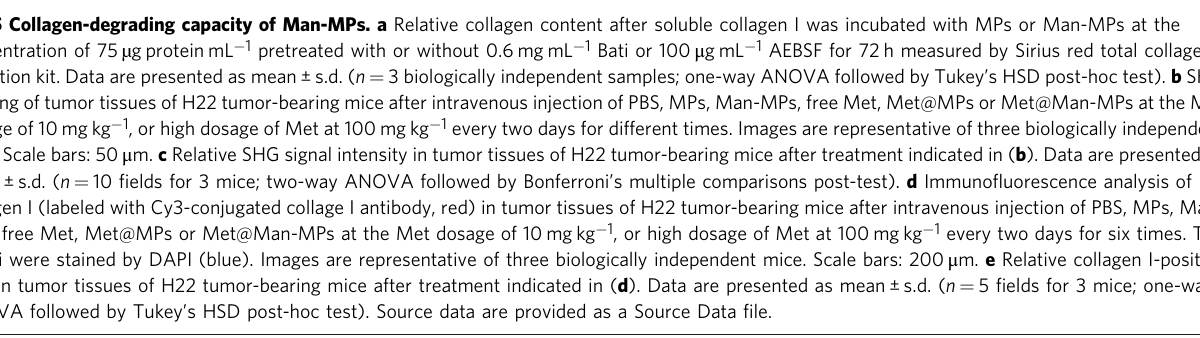
Fig. 5 Collagen-degrading capacity of Man-MPs. a Relative collagen content after soluble collagen I was incubated with MPs or Man-MPs at the concentration of 75 µ g protein mL − 1 pretreated with or without 0.6 mg mL − 1 Bati or 100 μ g mL − 1 AEBSF for 72 h measured by Sirius red total collagen detection kit. Data are presented as mean ± s.d. ( n = 3 biologically independent samples; one-way ANOVA followed by Tukey ’ s HSD post-hoc test). b SHG imaging of tumor tissues of H22 tumor-bearing mice after intravenous injection of PBS, MPs, Man-MPs, free Met, Met@MPs or Met@Man-MPs at the Met dosage of 10 mg kg − 1 , or high dosage of Met at 100 mg kg − 1 every two days for different times. Images are representative of three biologically independent mice. Scale bars: 50 μ m. c Relative SHG signal intensity in tumor tissues of H22 tumor-bearing mice after treatment indicated in ( b ). Data are presented as mean ± s.d. ( n = 10 fi elds for 3 mice; two-way ANOVA followed by Bonferroni ’ s multiple comparisons post-test). d Immuno fl uorescence analysis of collagen I (labeled with Cy3-conjugated collage I antibody, red) in tumor tissues of H22 tumor-bearing mice after intravenous injection of PBS, MPs, Man- MPs, free Met, Met@MPs or Met@Man-MPs at the Met dosage of 10 mg kg − 1 , or high dosage of Met at 100 mg kg − 1 every two days for six times. The nuclei were stained by DAPI (blue). Images are representative of three biologically independent mice. Scale bars: 200 μ m. e Relative collagen I-positive area in tumor tissues of H22 tumor-bearing mice after treatment indicated in ( d ). Data are presented as mean ± s.d. ( n = 5 fi elds for 3 mice; one-way ANOVA followed by Tukey ’ s HSD post-hoc test). Source data are provided as a Source Data fi